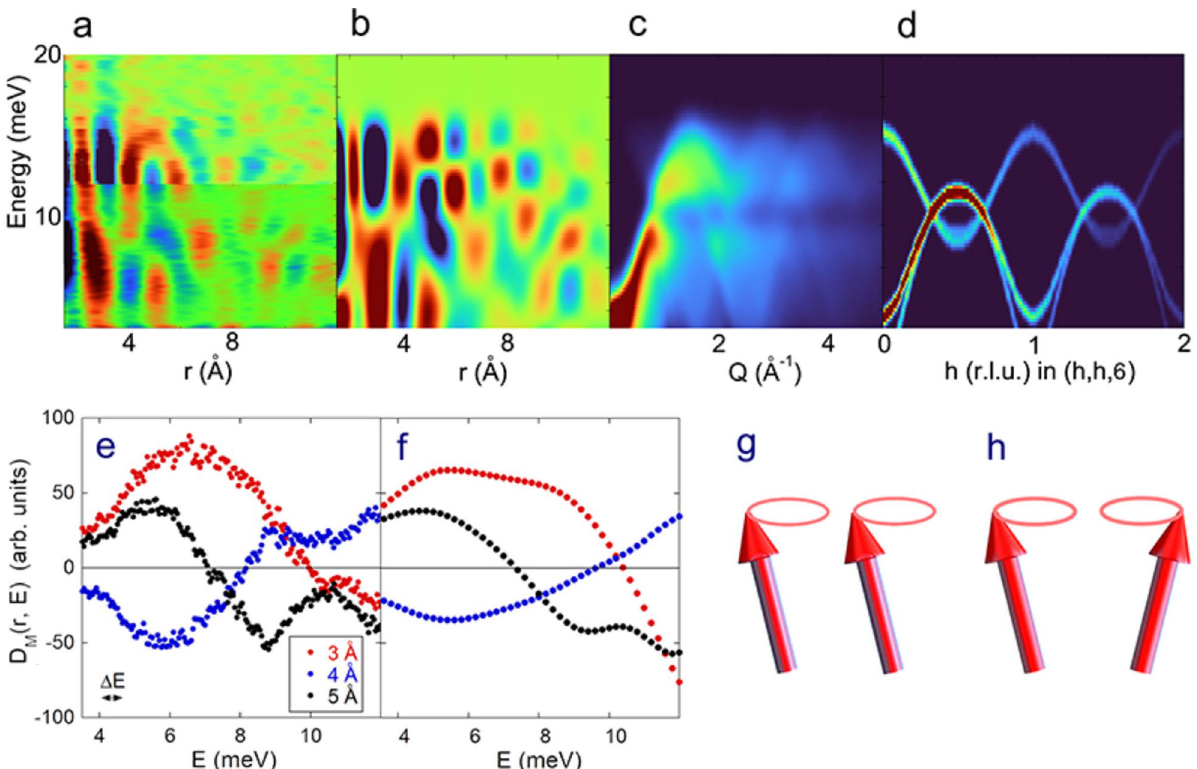
Figure 4. (a) Combined DymPDF D M ( r, E ) pattern at T = 8 K measured with E i = 18 ( E < 12 meV) and 46 meV ( E > 12 meV). The magnon mode transition at r = 3 Å is observed at about 10 meV. ( b) Simulated D M cal ( r, E ) pattern based on the SpinW powder averaged magnon dispersions 14 . ( c) Powder averaged S M cal ( Q, E )/< n ( E ) + 1